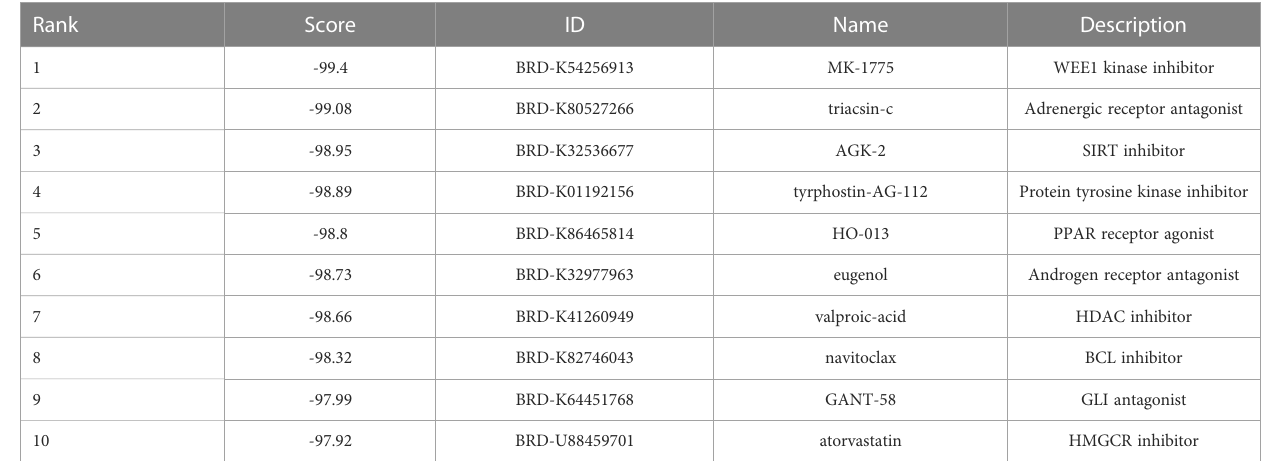
TABLE 2 Top 10 list of drugs name after CMap